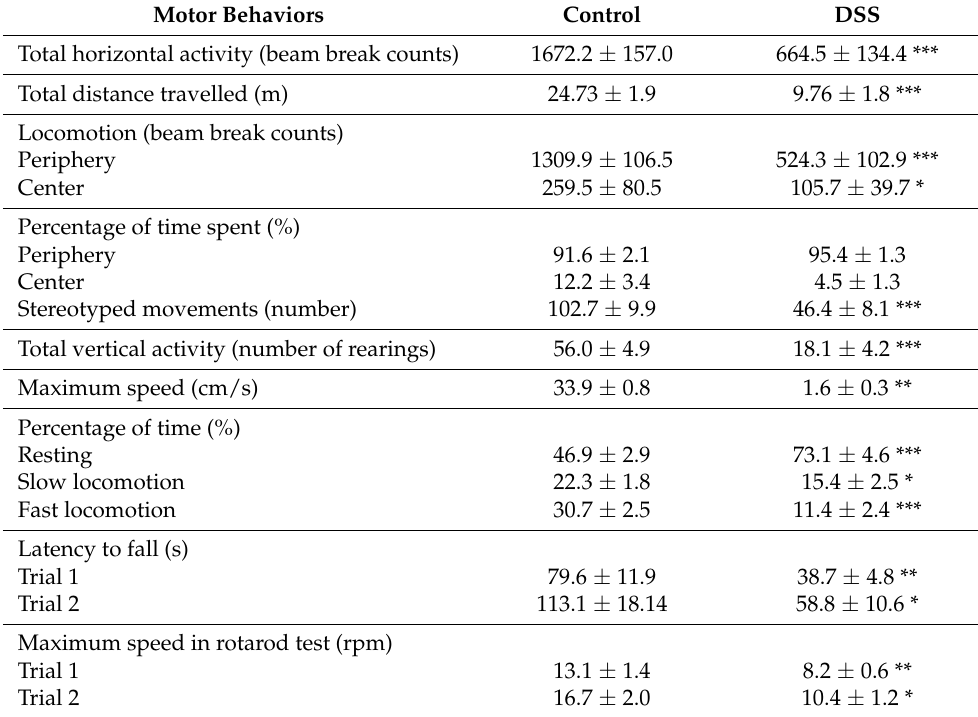
Table 2. Effects of DSS-induced acute colon inflammation on locomotion and motor